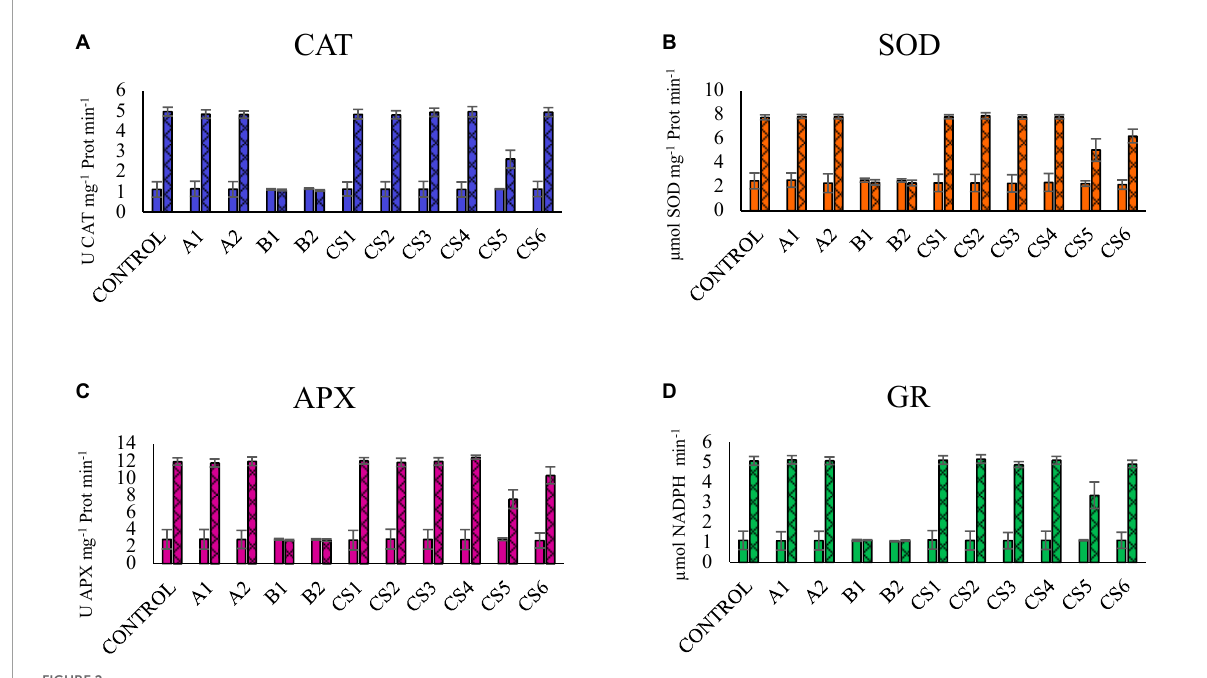
FIGURE2 Comparison of the results of the enzymatic activity of CAT (A) , SOD (B) , APX (C) , and GR (D) in plants grown in the substrate without Hg (smooth) vs. with a high concentration of Hg (double scratching). The bars indicate the standard